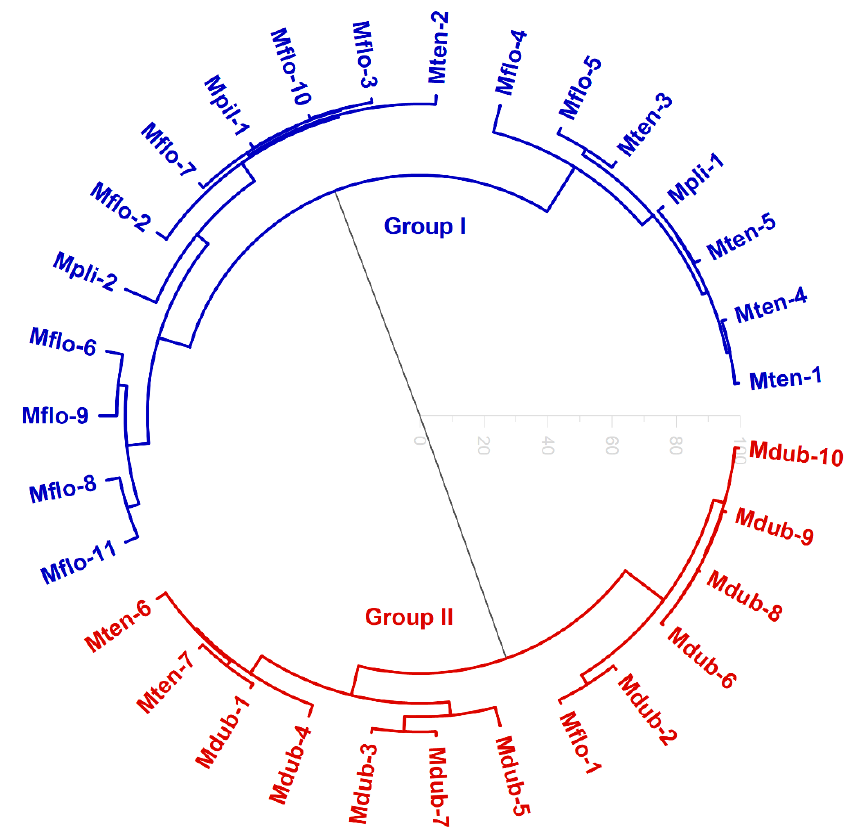
Figure 2. Hierarchical cluster analysis (HCA, in circular mode) of Myrciaria volatile samples. The PCA total analysis (Figure 3) explained 66.6% of the data variability. The PC1 explained 40.8% of the data, showing positive correlations with monoterpene hydrocarbons (MH, λ = 0.661), oxygenated monoterpenes (OM, λ = 0.008) and other compounds (OT, λ = 0.280), and negative correlations with sesquiterpene hydrocarbons SH, ( λ = − 0.470) and oxygenated sesquiterpenes (OS, λ = − 0.513). The PC2 explained 25.8% of the data, showing a positive correlation with sesquiterpene hydrocarbons (SH, λ =0.494) and other compounds (OT, λ = 0.509), and a negative correlation with monoterpene hydrocarbons (MH, λ = − 0.033), oxygenated monoterpenes (OM, λ = − 0.667) and oxygenated sesquiterpenes (OS, λ = − 0.227). Similar to HCA, the PCA analysis confirmed the formation of two distinct groups.